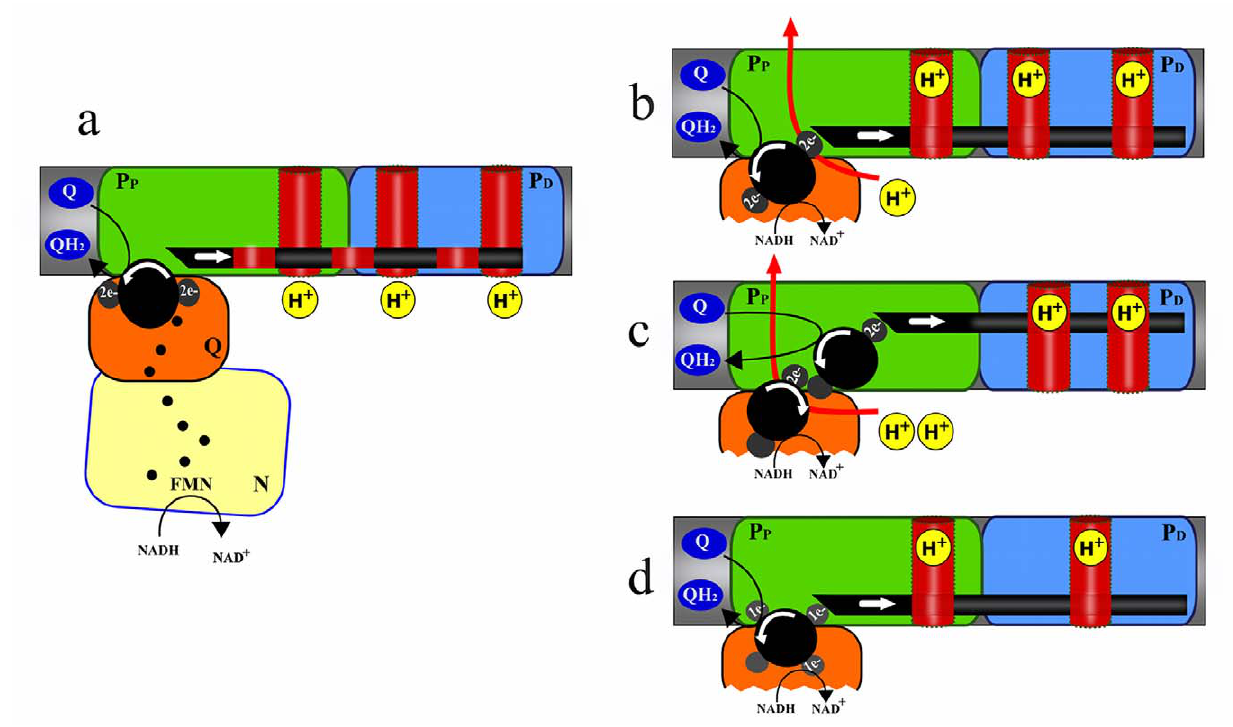
Figure 2. Schematic model of complex I with four functional modules as proposed by Hunte et al. [ 14 ] . (a) Representation of the rod model of coupling between electron transfer and proton extrusion. (b) The proton pathways according to the chimera model proposed by Friedrich and Sazanov [13,15]. (c) Scheme representing the model proposed by Ohnishi and Salerno [16,17]. (d) Representation of the indirect model recently proposed by Brandt [20]. P p indicates the proximal proton pumping domain.